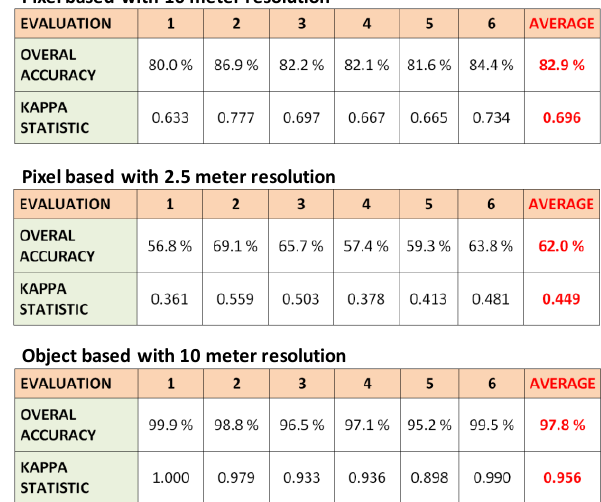
Accuracy evaluations were conducted for all classification results, and the evaluation results were shown in Figure 6.